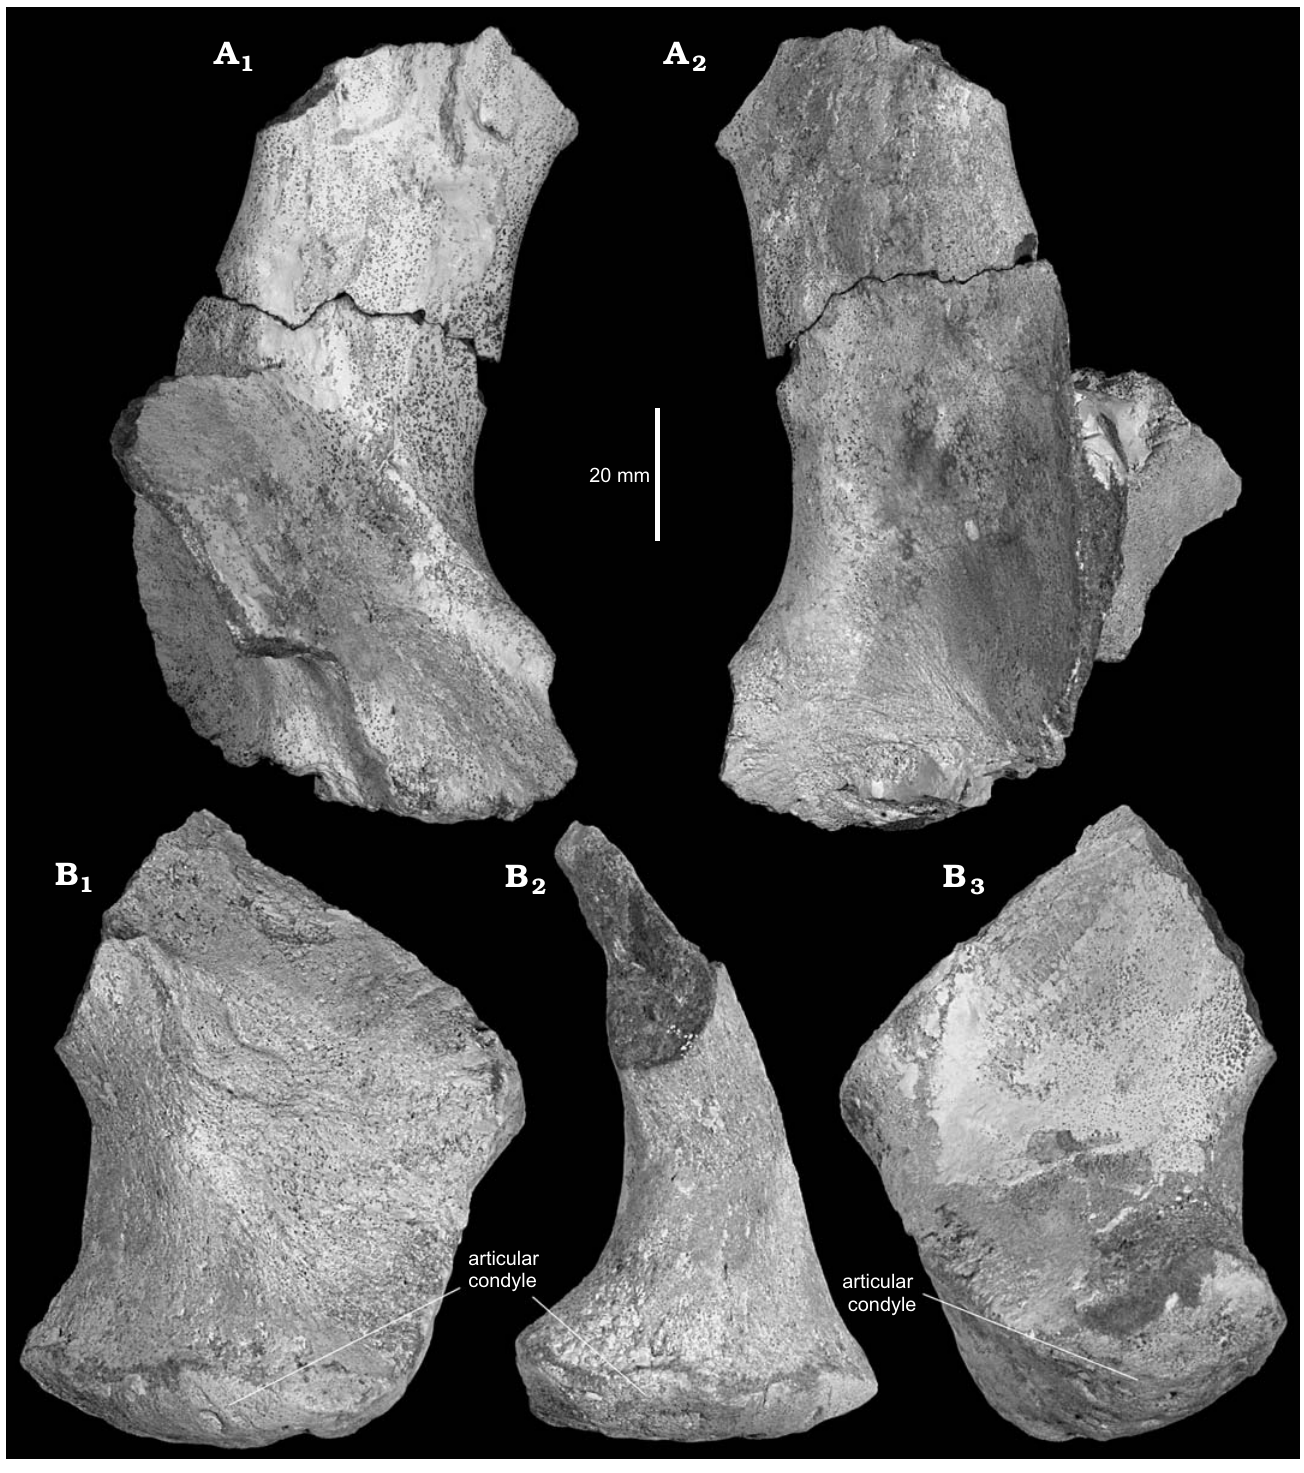
Fig. 2. Morphology of skull bones of ophthalmosaurid ichthyosaur Cryopterygius kielanae sp. nov. (GMUL 3579-81, holotype) from the Late Jurassic of Owadów-Brzezinki Quarry. A . Left pterygoid in ventral (A 1 ) and dorsal (A 2 ) views. B . Left quadrate in lateral (B 1 ), anterior (B 2 ), and medial (B 3 )